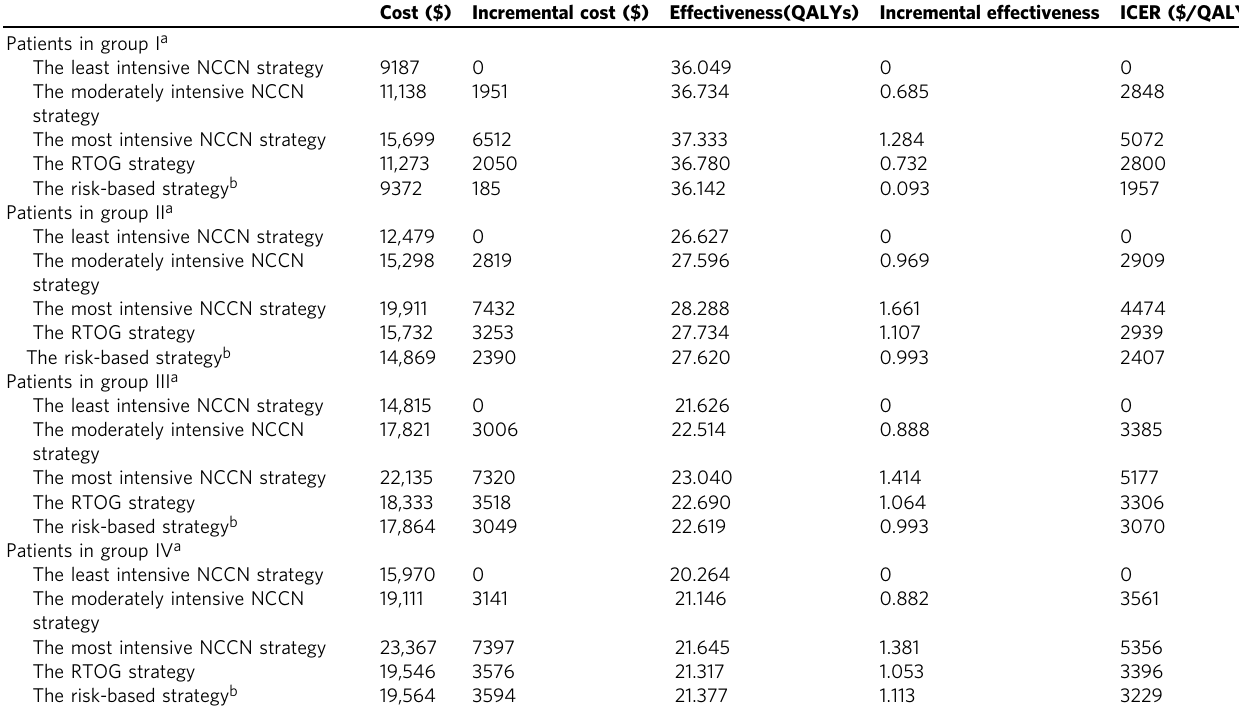
Table 2 Baseline cost-effectiveness analysis in Markov models.